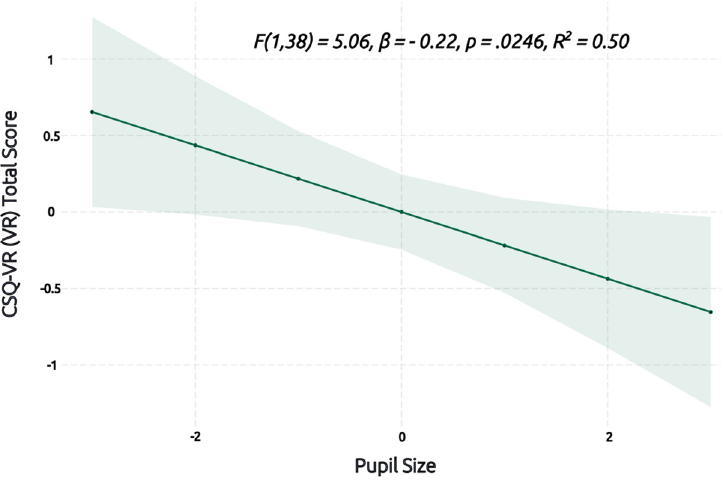
Figure 8. Mixed Regression Model of Pupil Size Predicting Cybersickness